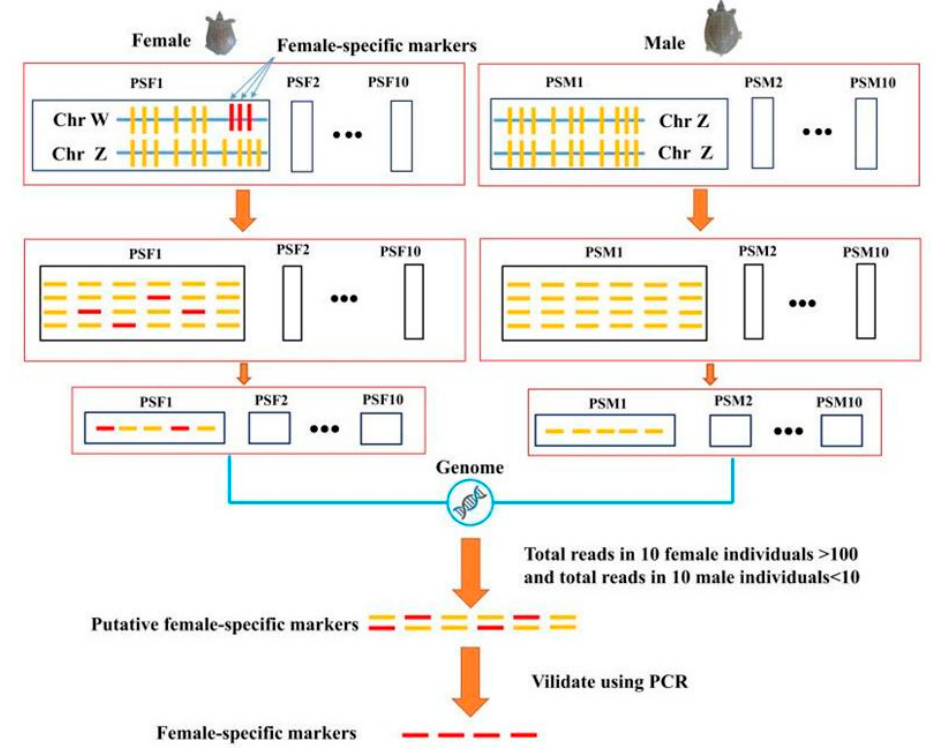
Figure 1. Workflow of sex-specific marker development in the Pelodiscus sinensis based on restriction site-associated DNA sequencing (RAD-seq). Table 2 . Raw data information from RAD-Seq.